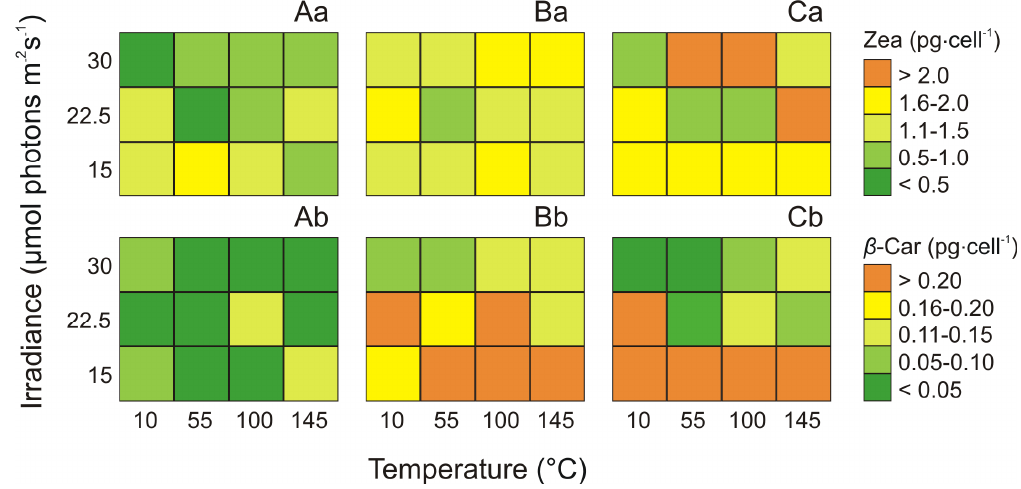
Figure 4. Changes in content (pg ∙ cell − 1 ) of Zea ( a ) and β ‐ Car ( b ) obtained after 14 days of experiment for three phenotypes of Synechococcus sp.: Type 1 ( A ), Type 2 ( B ), Type 3a ( C ) under different irradiance ( μ mol photons m − 2 s − 1 ) and temperature (°C) conditions.